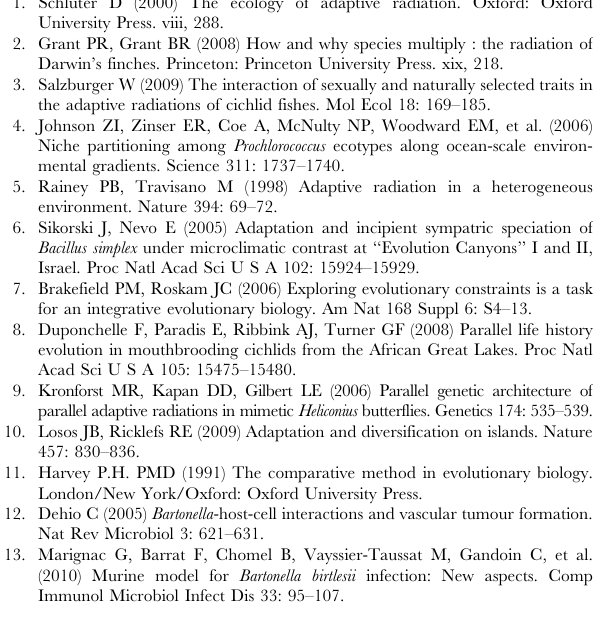
v . Genes with v , 0.25, but with sites under positive selection are indicated by gray color. virB T4SS and bep genes are indicated by orange color. Orthologous genes present in genomes of other lineages are shown. Likelihood-ratio-test (LRT) results of the CodeML selection analysis are given for comparison of model M2a versus M1a and model M8 versus M7. Table S3 Genes of lineage 4 with average d n/ d s values ( v ) $ 0.25 and/or site-specific positive selection detected by CodeML (model M2a versus model M1a). Genes are ordered according to v . Genes with v , 0.25, but with sites under positive selection are indicated by gray color. virB T4SS, bep , and trw T4SS genes are indicated by orange color. Orthologous genes present in genomes of other lineages are shown. Likelihood-ratio-test (LRT) results of the CodeML selection analysis are given for comparison of model M2a versus M1a and model M8 versus M7. Table S4 Prediction of tyrosine-phosphorylation sites for Beps of Bep clade 9 using NetPhos2.0 [52], ScanSite [53], and KinasePhos [54]. Except for BARCL_1035, tandem-repeated motifs were detected in all genes of Bep clade 9. Table S5 454-sequencing and newbler-assemby data for ge- nomes sequenced in this